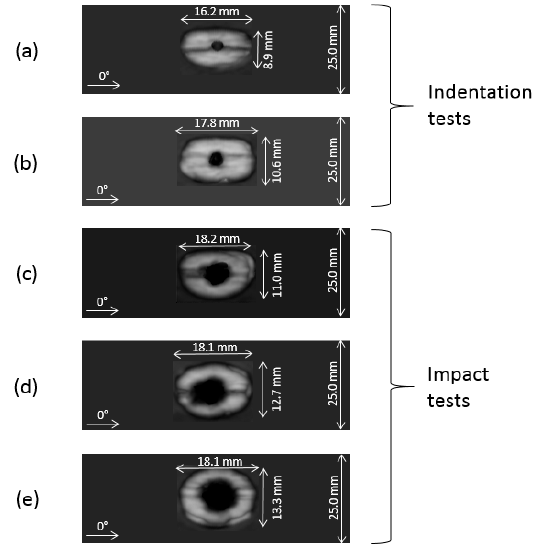
Figure 6. C-scan: images of reference damaged specimens. ( a ) Indented Interrupted (Ind_Int), ( b ) Indented Fully Damaged (Ind_FD), ( c ) impact at 2.2 J (DT_E1), ( d ) impact at 3.2 J (DT_E2), ( e ) impact at 4.2 J